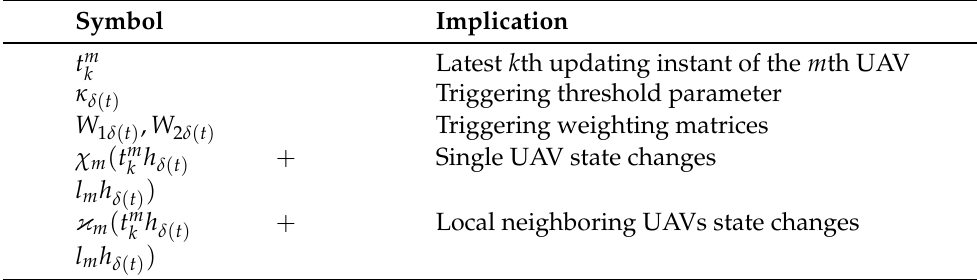
Table 2. Notation of event triggering